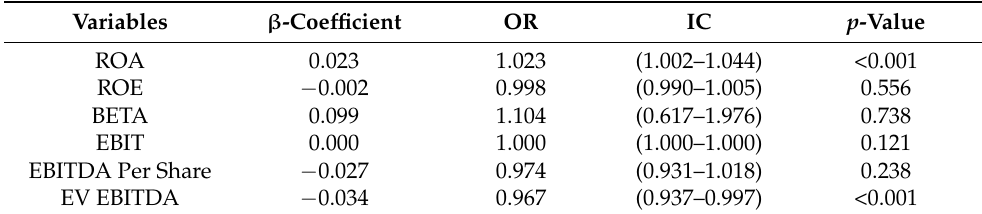
Table 5. The multivariate logistic regression